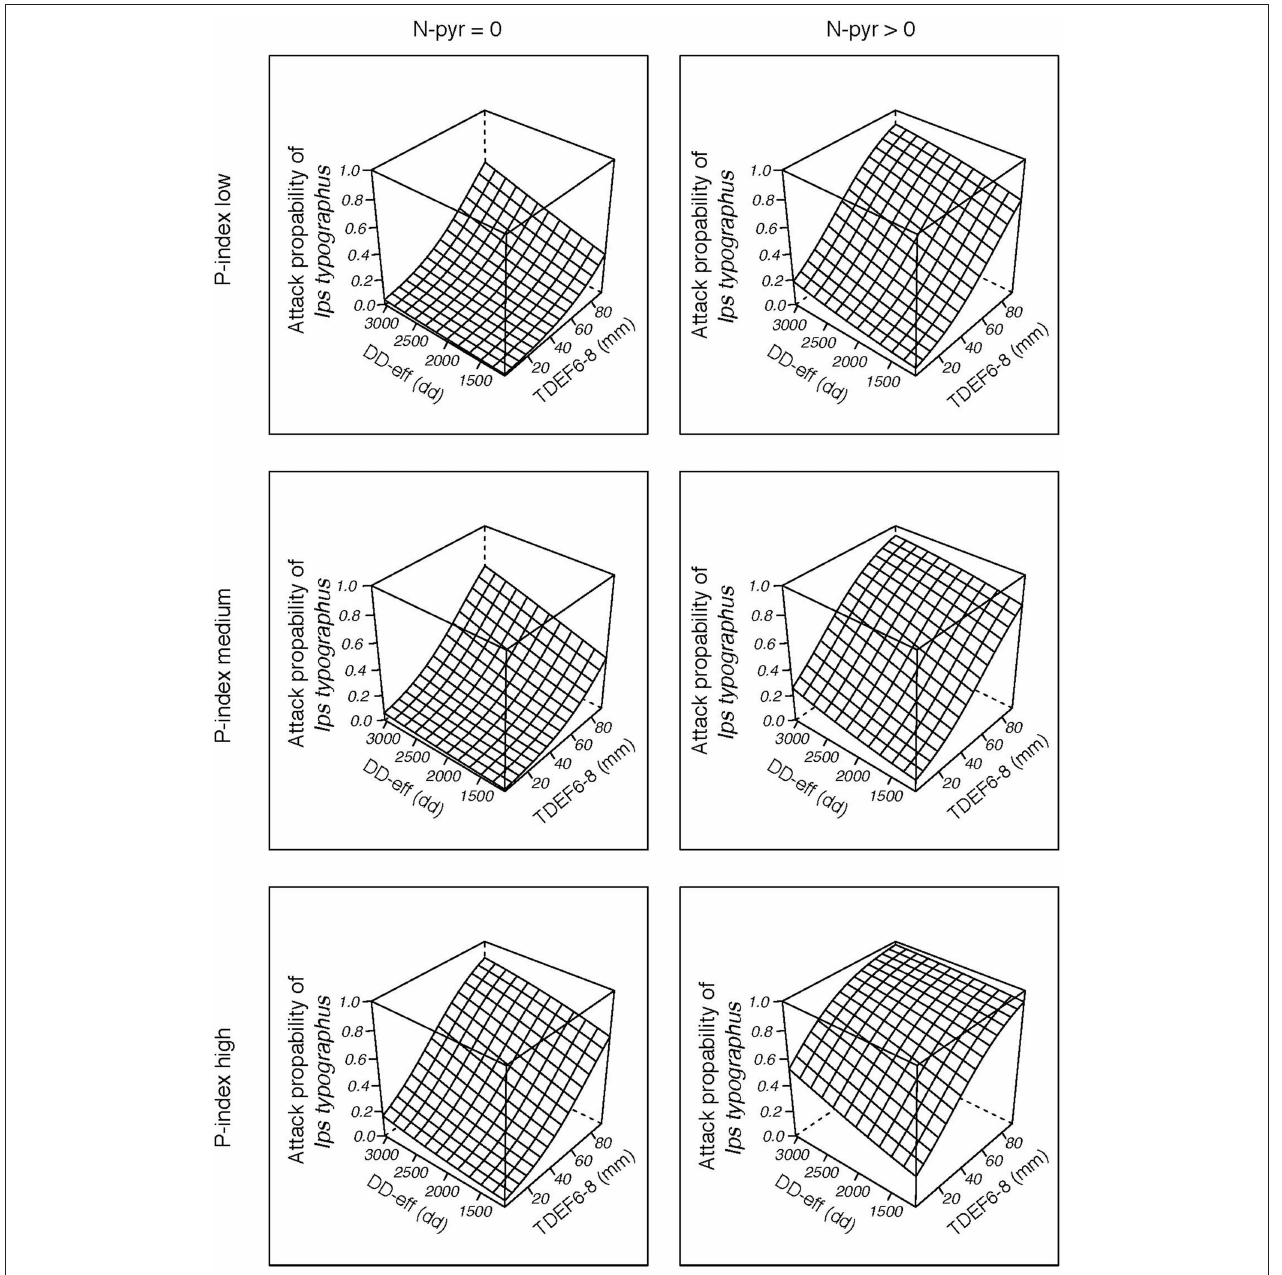
FIGURE 8 | Probability of bark beetle attack for “Waldviertel-Voralpen” (WV) (2014–2016) as a function of effective thermal sum for I. typographus attack (DD-eff), transpiration deficits from June to August (TDEF6-8) accumulated in the current year, the occurrence of salvage loggings in the preceding year (N-pyr) and category of stand predisposition index (smallest/ medium/ highest P-index). The remaining, scaled variables of the binary logistic regression function were set to their means ( = zero).